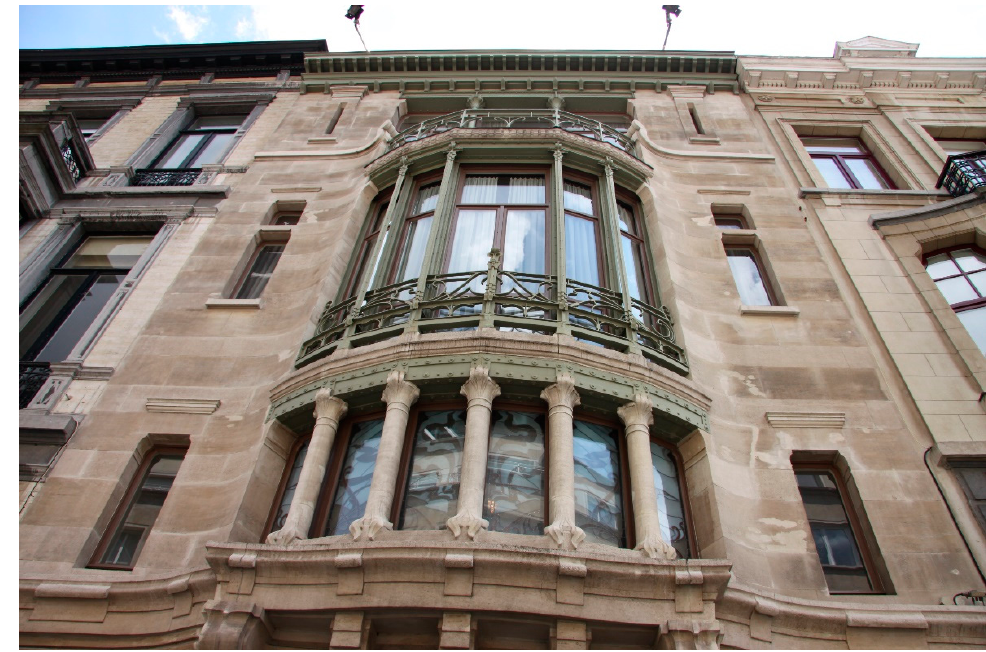
Figure 2. The biomorphic columns in the Tassel House façade.